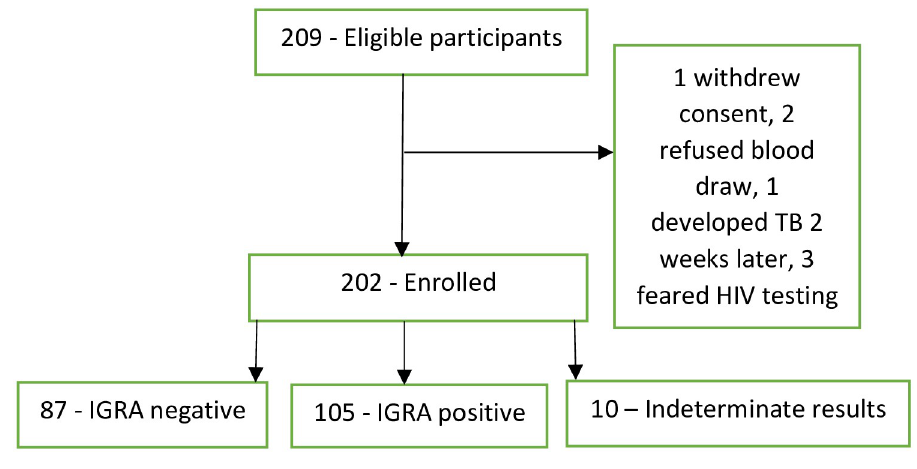
Fig 1. Subject recruitment and IGRA